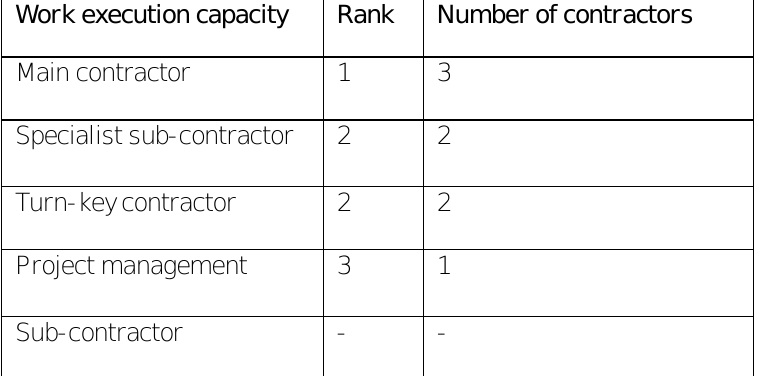
Table 7: Contractor's role overseas